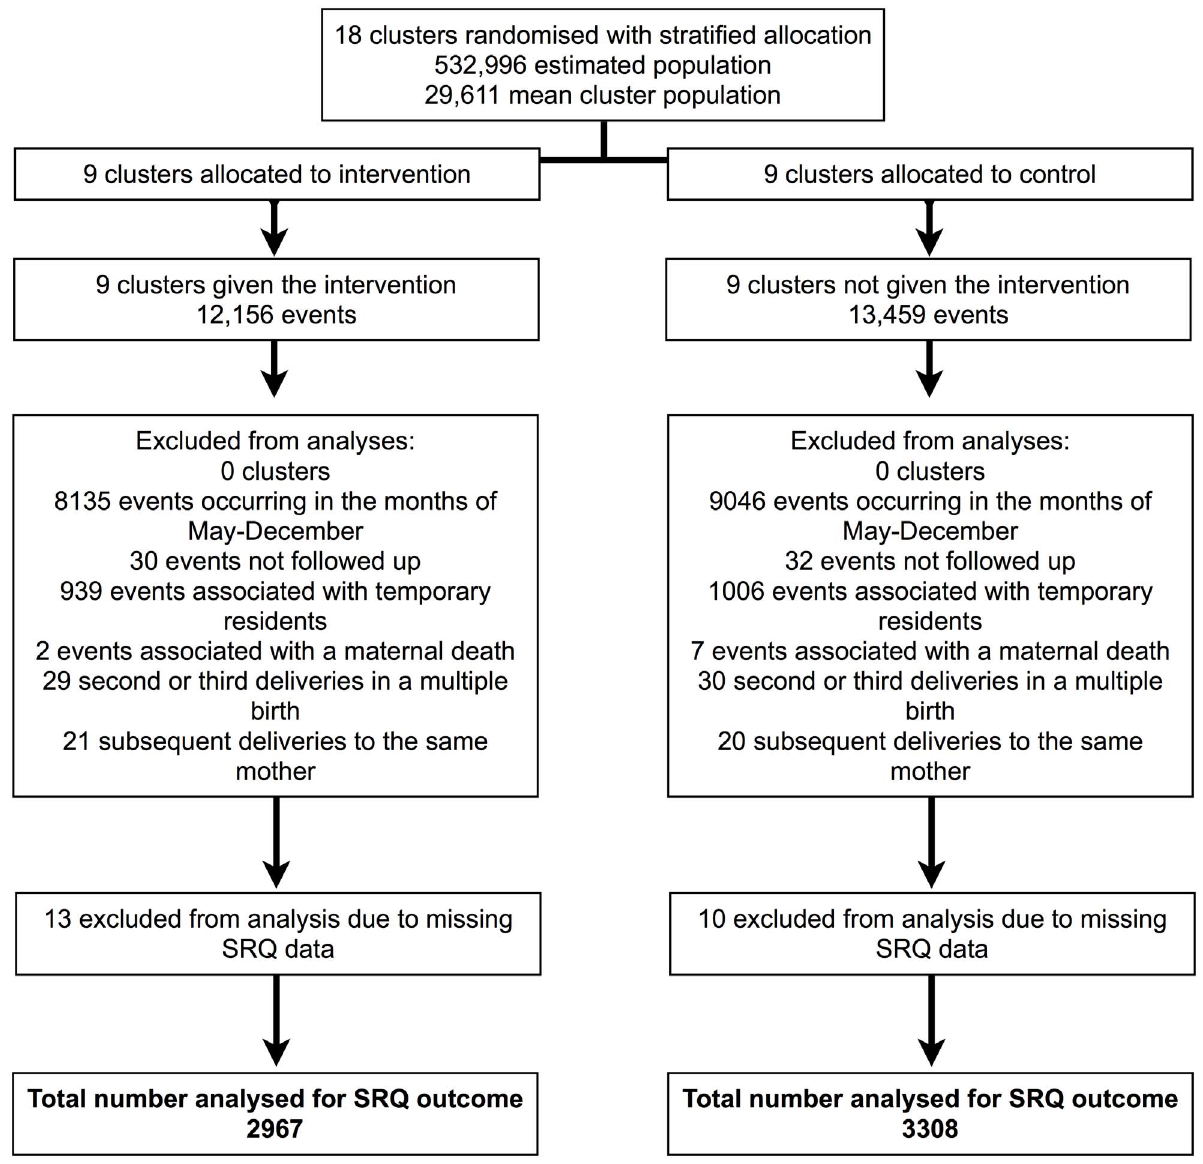
Figure 1. Sample selection procedure for evaluation of the effect of women’s groups on postpartum psychological distress. From 25,615 births and deaths (‘events’) over the 24 study months in 2010 and 2011 we excluded data from: 17,181 events that did not occur within the SRQ-20 data collection periods; 62 events where it was not possible to conduct an interview due to migration or refusal; 1945 events associated with mothers who were temporary residents in the study area; nine events associated with a maternal death; 100 events associated with mothers who had previously delivered during the SRQ-20 data collection periods, either because of multiple births or through repeated births; 23 mothers due to missing SRQ-20 data. In total, 6275 mothers were included in the final sample.